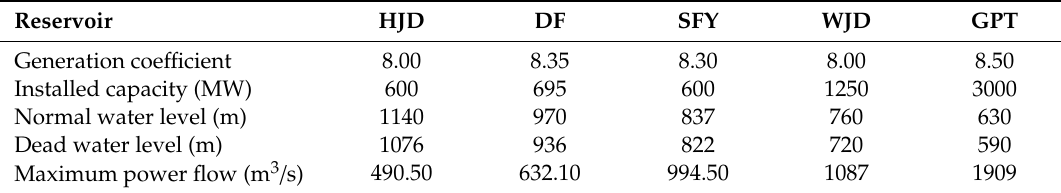
Table 9. Comparison of original load and optimized loads obtained by five algorithms in spring.